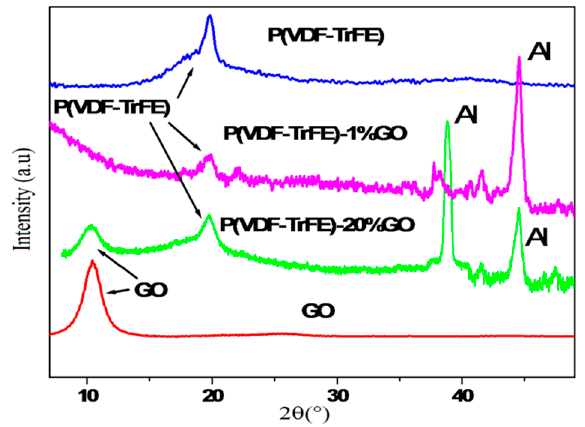
Figure 1. X-ray di ff raction patterns of poly-trifluoroethylene P(VDF-TrFE), graphene oxide and Figure 1. X-ray diffraction patterns of poly-trifluoroethylene P(VDF-TrFE), Graphene oxide and P(VDF-TrFE)-graphene oxide / Al fibers. P(VDF-TrFE)-Graphene oxide/Al fibers.